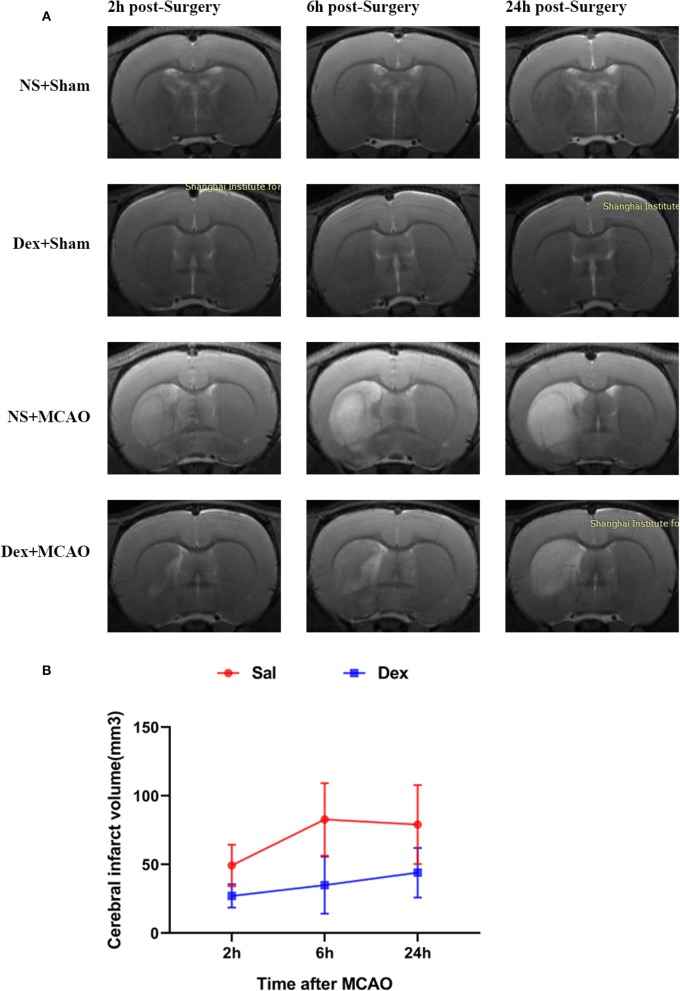
Dexmedetomidine pretreatment reduced the cerebral infarct volume. MRI analysis was conducted at 2, 6, and 24 h after MCAO. (A) T2-weighted MRI images of brain from 4 groups at 2, 6, and 24 h post-MCAO. (B) Dexmedetomidine pretreatment significantly reduced the infarct volume after MCAO, but it didn't in a time-dependent manner. Infarct volume are expressed as mean ± SD (n sample= 8 animals per group).